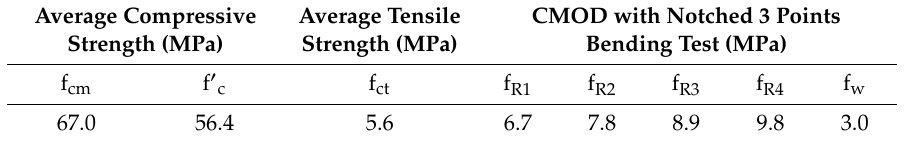
Table3. Averagecompressivestrength, tensilestrengthandresidualtensilestrengthoftheAACconcrete.